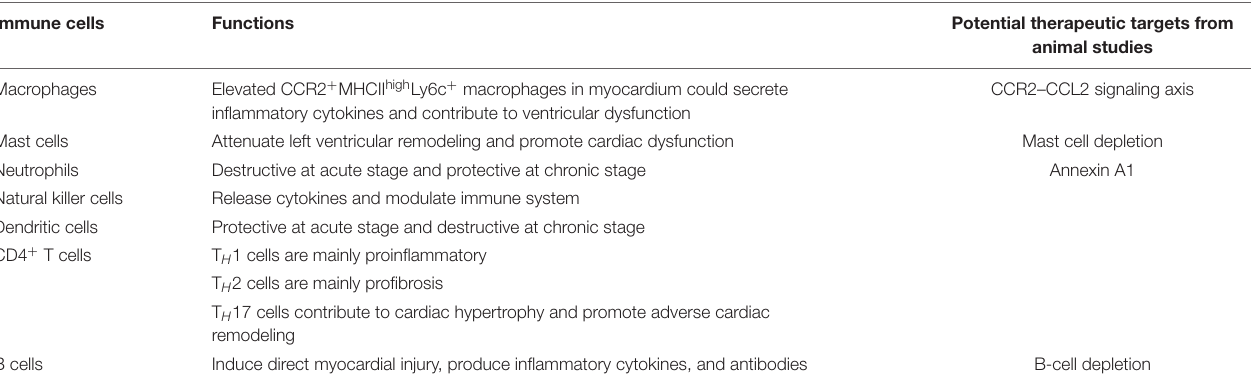
TABLE 2 | Main immune cells in heart